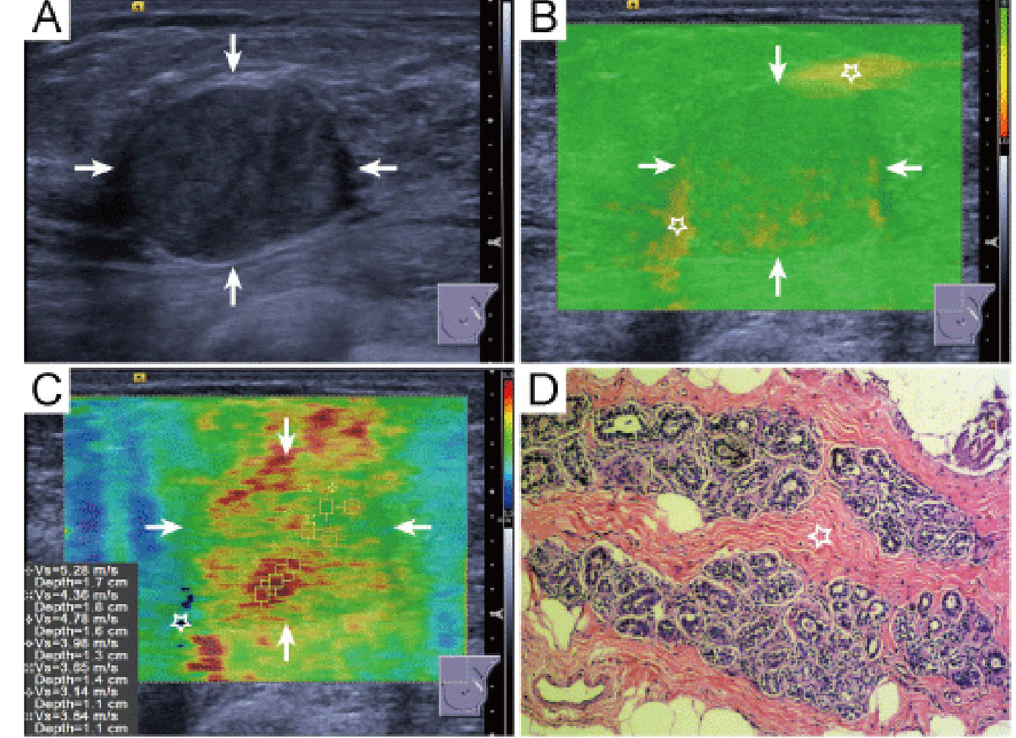
Figure 4. Fibroadenoma in a 35 years old woman. ( A ) The lesion (arrows) is classified as US BI-RADS category 4a on B-mode US. ( B ) The periphery of lesion (arrows) is covered by yellow color (five-pointed star) indicating low QM on QM mode of shear wave speed imaging. ( C ) The SWS max of the lesion (arrows) is 5.28 m/sec. ( D ) Pathological examination confirms the diagnosis of fibroadenoma. The five-pointed star shows the dense fibrillar component. (hematoxylin-eosin stain; original magnification, × 100). QM = quality